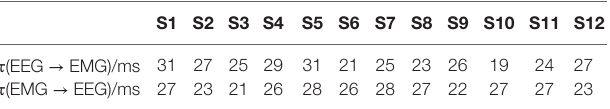
TaBle 2 | Delay time of all the subjects (ms).